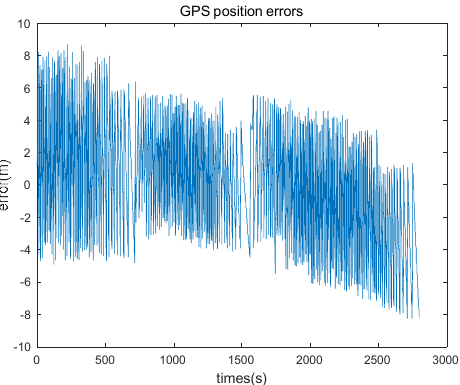
Figure 6. Outdoor experimental tests by GPS + IMU method.